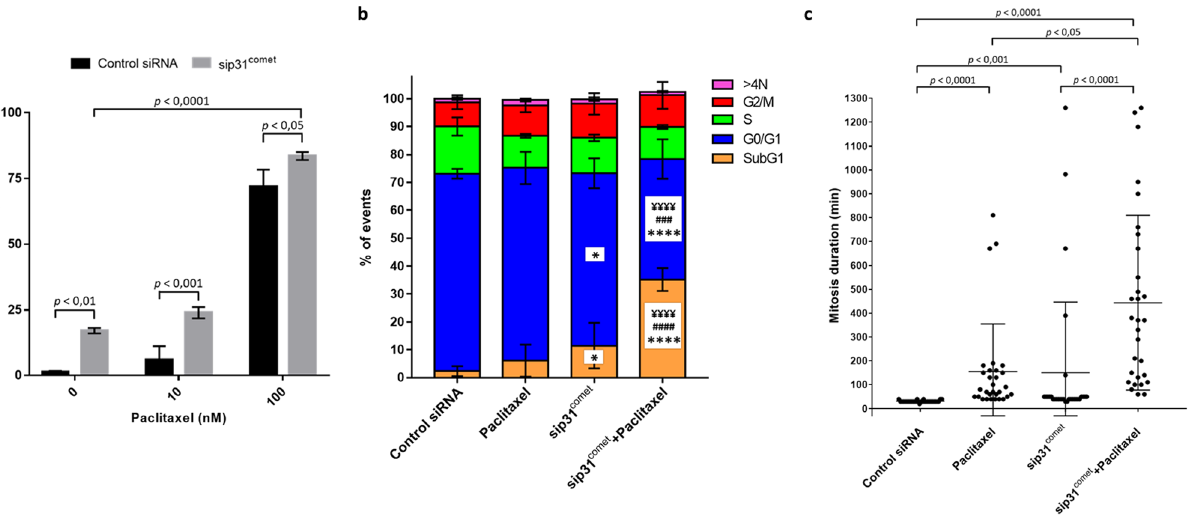
Figure 3. p31 comet knockdown increases the mitotic index and the duration of the mitotic block, and enhances cancer cells death under low doses of paclitaxel treatment. NCI-H460 cells were treated with control or p31 comet siRNAs for 48 h, then 10 nM of paclitaxel was added for further 24 h or 48 h. ( a ) Determination of the mitotic index 24 h after addition of paclitaxel, as determined phase-contrast microscopy. Two-way ANOVA with Tukey’s multiple comparisons test was used for statistical analysis. ( b ) Cell cycle analysis. 48 h after the addition of paclitaxel, cells were treated with propidium iodide/RNase and analyzed by flow cytometry. * p < 0.05, **** p < 0.0001, sip31 comet or sip31 comet + paclitaxel vs control siRNA; ### p < 0.001, #### p < 0.0001, sip31 comet + paclitaxel vs sip31 comet ; ¥¥¥¥ p < 0.0001, sip31 comet + paclitaxel vs paclitaxel, by two-way ANOVA with Tukey’s multiple comparisons test. ( c ) Quantification of mitosis duration. 24 h after paclitaxel treatment and/ or 48 h after siRNA transfection cells were followed by time-lapse imaging for 72 h. The scatter plot shows the time from mitosis entry to cell division. Each spot represents one cell. Statistical analysis was performed by Krushkal–Wallis with Dunn’s multiple correction test. The error bars represent mean ±